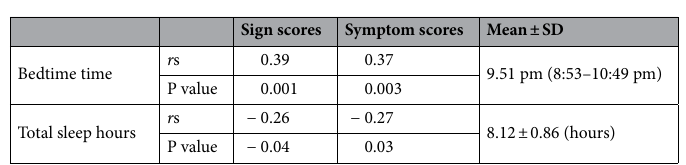
Table 2. The correlations between scores of ocular symptoms/signs and style of sleep.